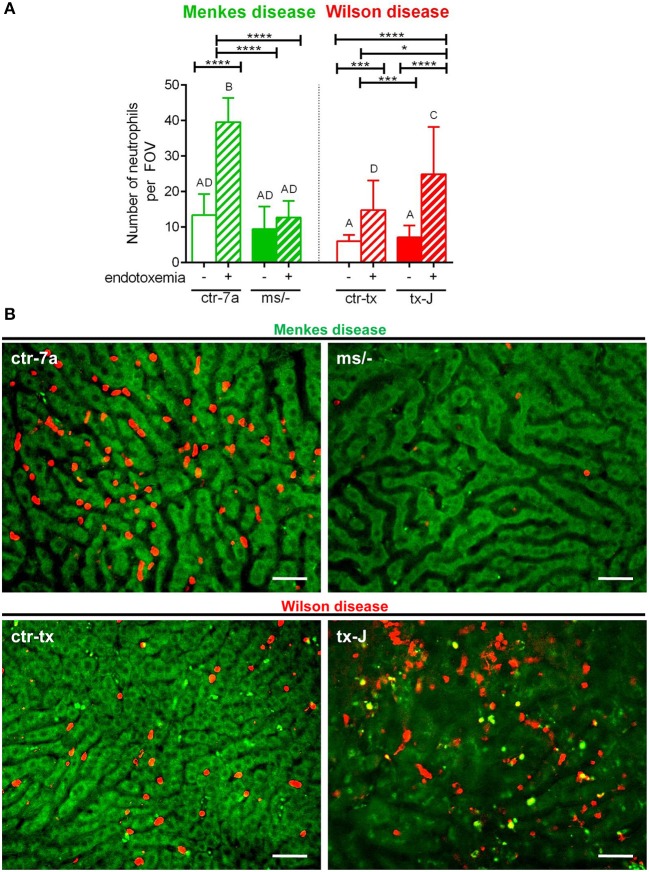
The presence of neutrophils in livers of Wilson (tx-J) and Menkes (ms/−) disease mice and their respective controls (ctr-tx and ctr-7a) with systemic inflammation. Neutrophils were counted per field of view (FOV; n = 3/group) (A). Asterisks indicate significant differences using unpaired two-tailed Student's t test (*P ≤ 0.05, ***P ≤ 0.001, ****P ≤ 0.0001) and one-way ANOVA (post hoc Bonferroni) test (different letters indicate statistically significant differences between groups). Representative images revealing neutrophil deposition in liver sinusoids are presented in (B). On images, autofluorescent hepatocytes (green) can be observed, and between them, sinusoids are seen as black areas. In the latter structures, neutrophils are deposited (false red color; Brilliant Violet 421 anti-Ly6G antibody). The scale bar indicates 50 μm.